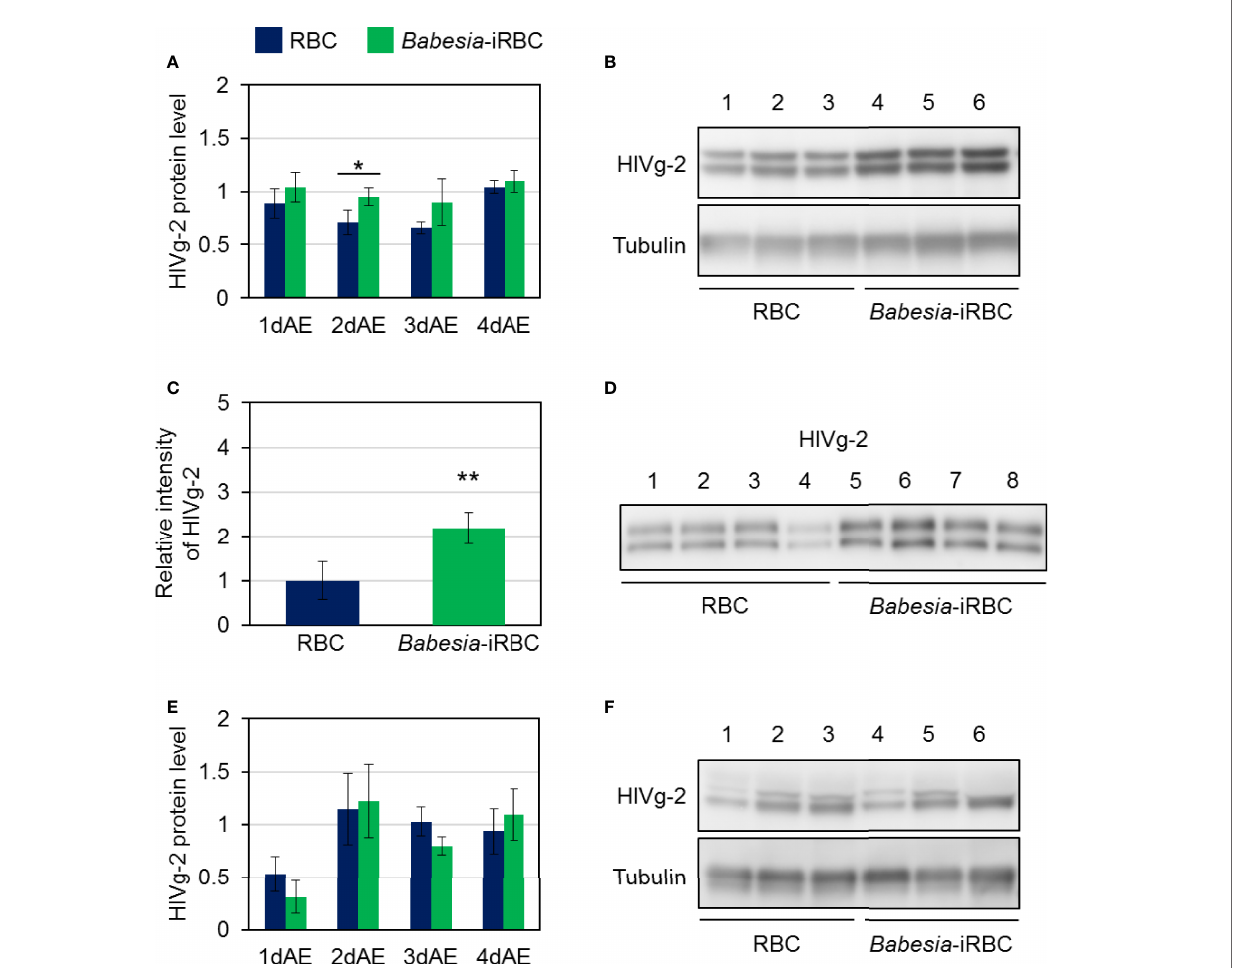
FIGURE 4 | HlVg-2 protein levels in (A, B) the fat body, (C, D) the hemolymph, and (E, F) the ovary after semiarti fi cial mouse skin membrane feeding with bovine red blood cells (RBC group) or with Babesia -infected bovine red blood cells ( Babesia -iRBC group). The protein was extracted from the fat body or ovary of engorged female ticks 1, 2, 3, and 4 days after engorgement (1dAE-4dAE) and from the hemolymph 2dAE. Western blotting was performed using an anti-HlVg-2 serum. Anti- H. longicornis tubulin serum was used as loading control for the fat body and ovary samples. Positive bands of HlVg-2 in (B) the fat body and in (F) the ovary 2dAE are shown in the upper panels while bands of tubulin are in the lower panels. Lanes 1 – 6 contain equal numbers of tick fat body and ovary (n = 3 per group). HlVg-2 protein levels (A, E) were calculated relative to the band intensities of tubulin signals in the same samples. (C, D) HlVg-2 in the hemolymph 2dAE was detected using western blotting. Relative intensities (C) of HlVg-2 in the Babesia -iRBC and in the RBC group were calculated on the basis of the intensities of positive bands (D) . Lanes 1 – 8 contain equal numbers of tick hemolymph (n = 4 per group). Data represent the mean ± SD. Asterisks indicate the signi fi cant differences between the RBC and Babesia -iRBC groups (* P < 0.05, ** P < 0.01 via Student ’ s